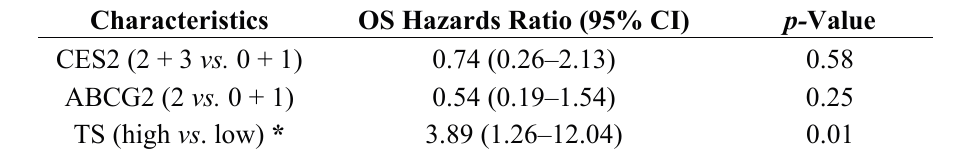
Table 3. Cox multivariate analysis of OS in a series of 58 metastatic colorectal cancer